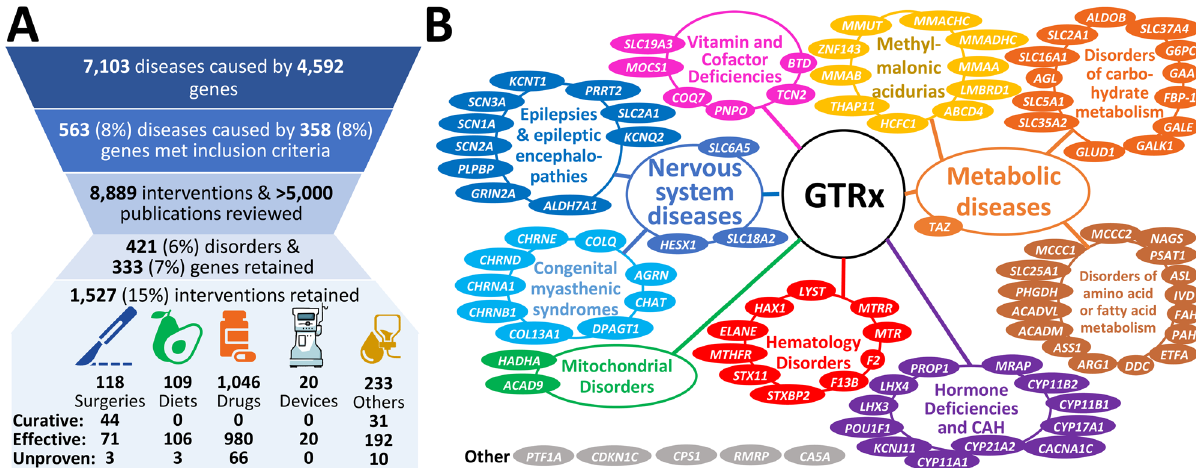
Fig. 3 GTRx disease, gene, and literature fi ltering, and fi nal content. A A modi fi ed PRISMA fl owchart showing fi ltering steps and summarizing results of review of 563 unique disease-gene dyads herein 86 . B Genetic disease types and disease genes featured in the fi rst 100 GTRx genes reviewed herein.